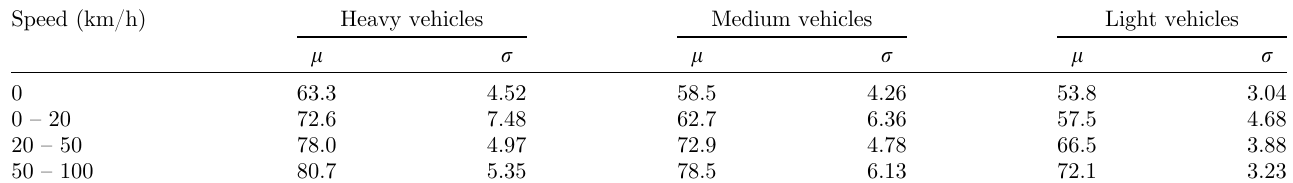
Table 1. The mean and standard deviation of noise emission of a single vehicle at 7.5 m (in dBA). Speed (km/h)